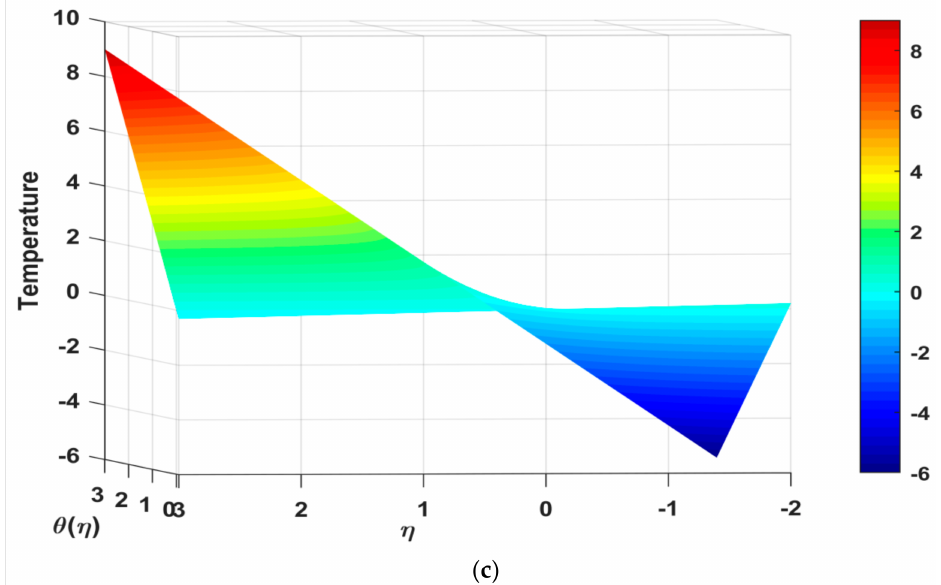
Figure 7. ( a ): Nephogram of f (cid:48) ( η ) under the influence of the study parameters. ( b ) Nephogram of g( η ) under the influence of the study parameters. ( c ) Nephogram of θ ( η ) under the influence of the study